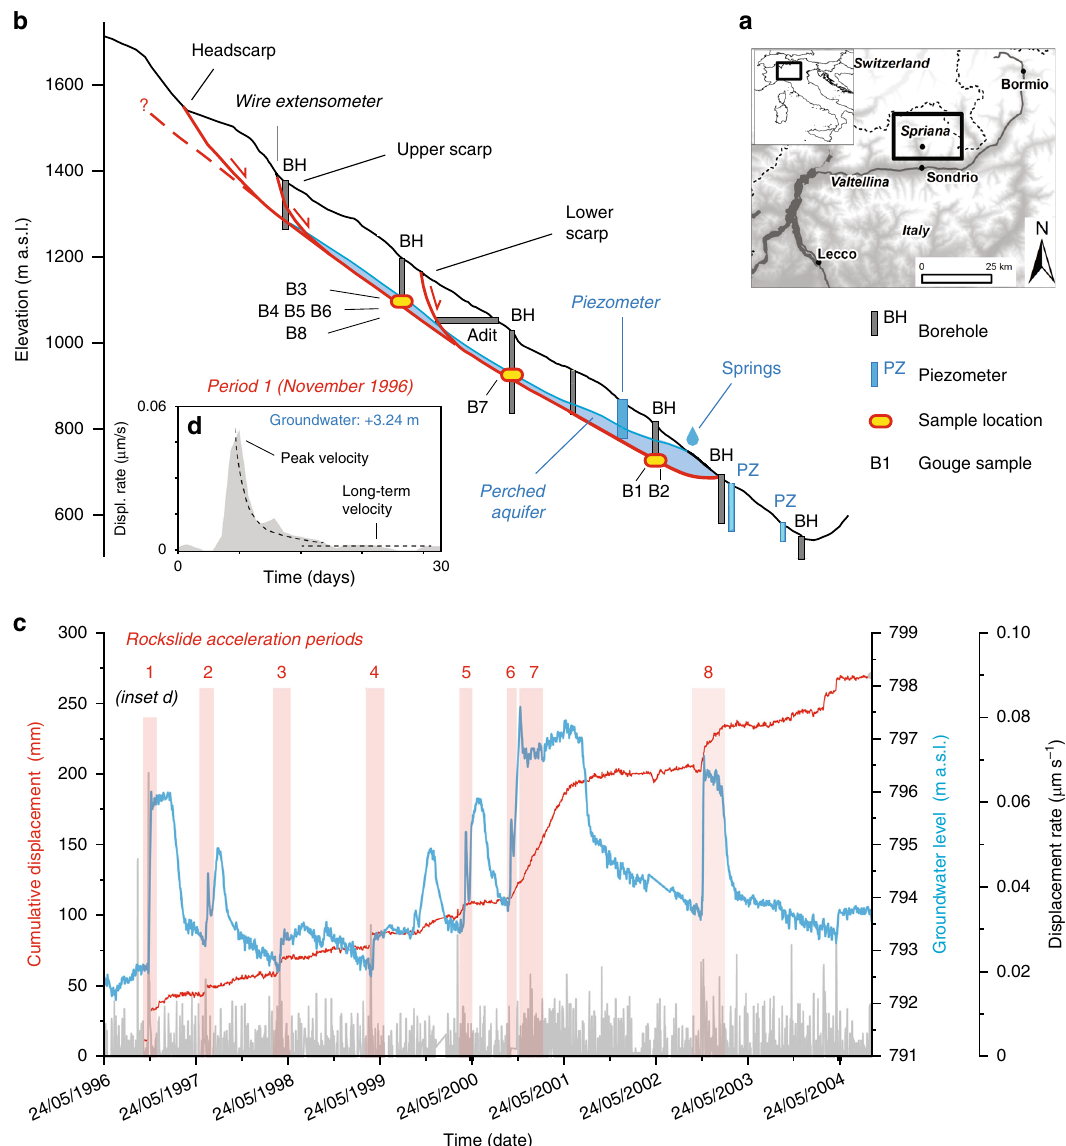
Fig. 1 Spriana rockslide. a Location map; b geological and hydrogeological model, with basal shear zone sampling locations, sample numbers and location of fi eld measuring devices used for the analysis. The representation of the perched aquifer integrates borehole and piezometer observations made upon 1989 – 90 site investigations. Horizontal and vertical distance are same scaling; c monitoring time series of rockslide surface displacement (wire extensometer) and groundwater level (hydraulic borehole piezometer), with selected rockslide acceleration periods outlined; d detail of acceleration impulse associated to a period of increase of groundwater level (acceleration period n.1) and characteristic descriptors: time to peak, peak velocity, long- term